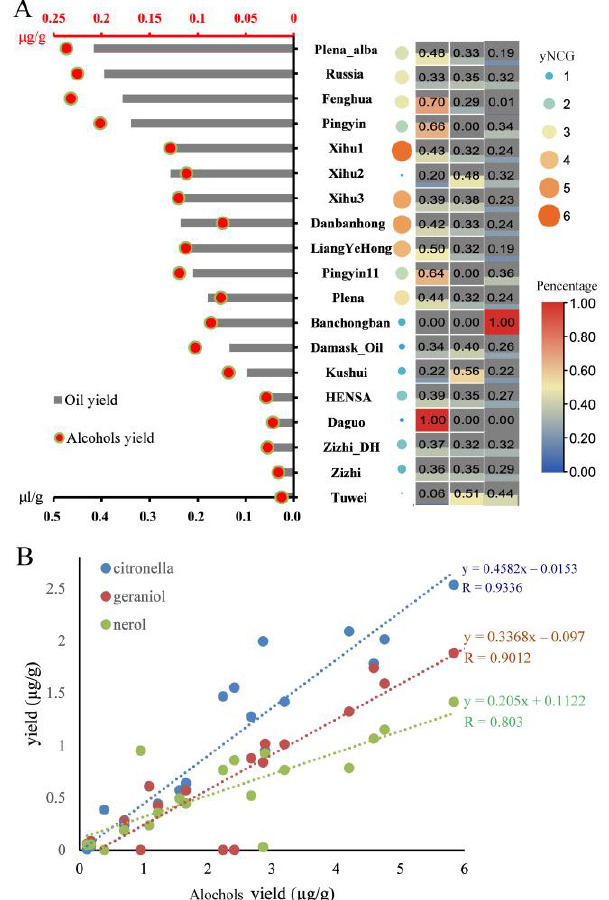
Figure 1. The yNCG (yields of nerol, citronellol and geraniol) was an alternative index of essential oil yield of oil bearing roses. ( A ) The oil yield (histogram), alcohols yield (scatter diagram), yNCG (heatmap, colors and areas of circles) and percentage of each compound (heat map, coloring areas and numbers in the boxes) of 19 rose cultivars. ( B ) Correlation between the alcohols yield and the total yields of nerol, citronellol and geraniol.